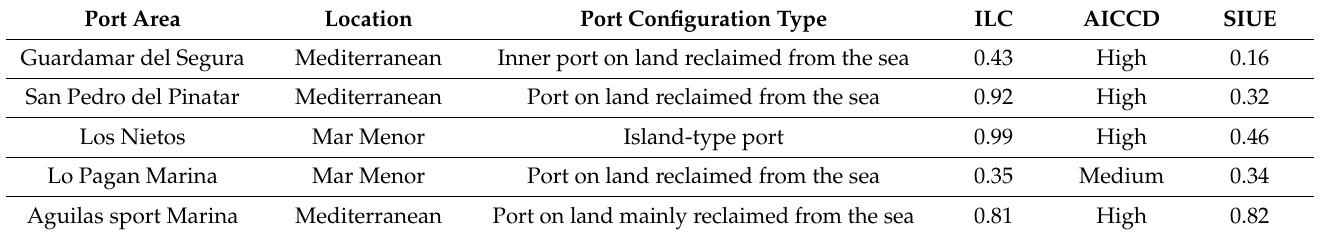
Figure 3. Aggregated tessellated large-scale distribution of port configuration indicators in the study area. Table 3. Some examples of values for port areas configuration indicators.